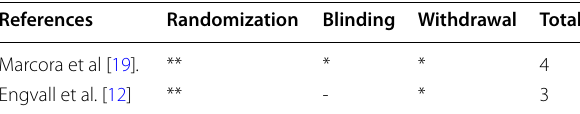
Table 2 Quality assessment of studies by Jadad scale (Oxford quality scoring